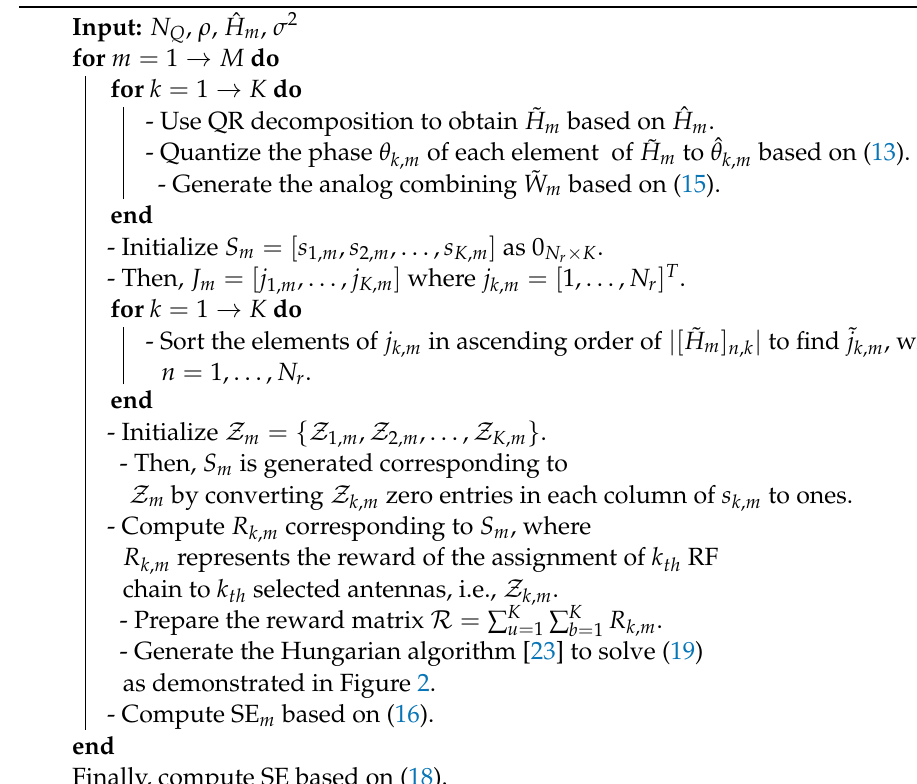
Algorithm 1: Matching strategy for RF chain-subset selected antennas based on the Hungarian